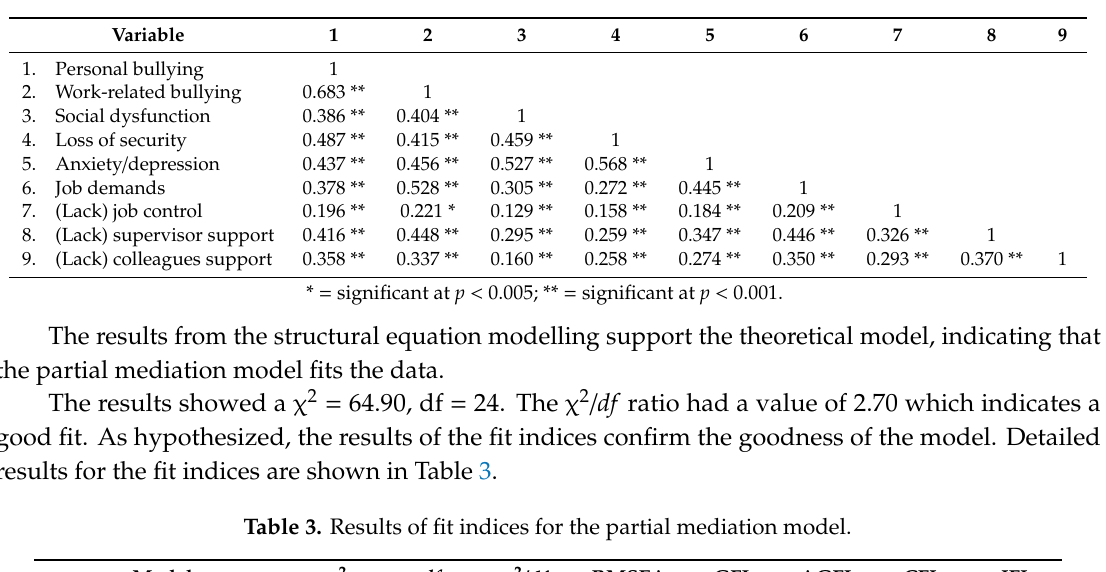
Table 2. Pearson’s correlation coe ffi cients of the variable of interest.